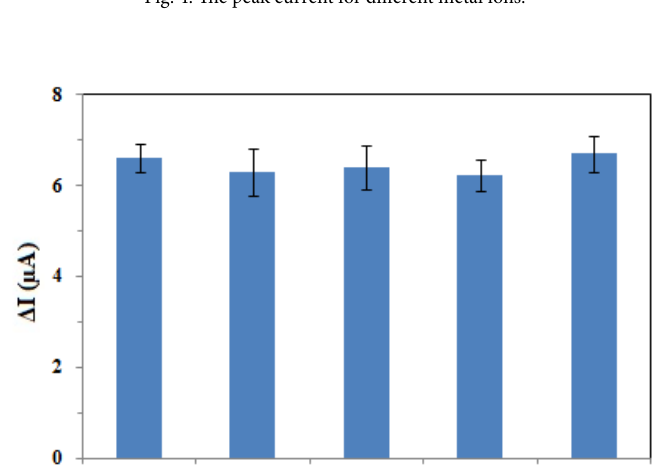
Fig. 4. The peak current for different metal ions. Figure 4. The peak current for different metal ions.